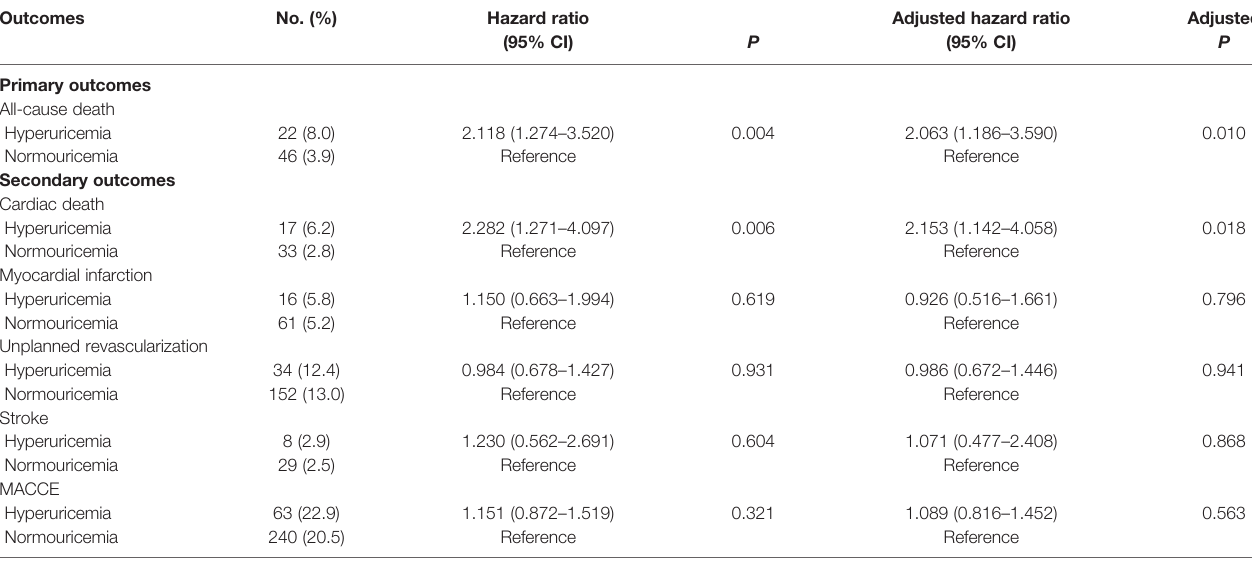
TABLE 3 | Risks of 5-year primary and secondary outcomes in patients with